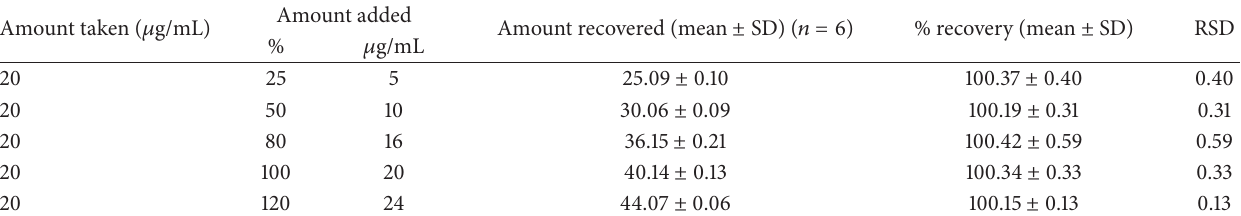
Table 2: Accuracy of the